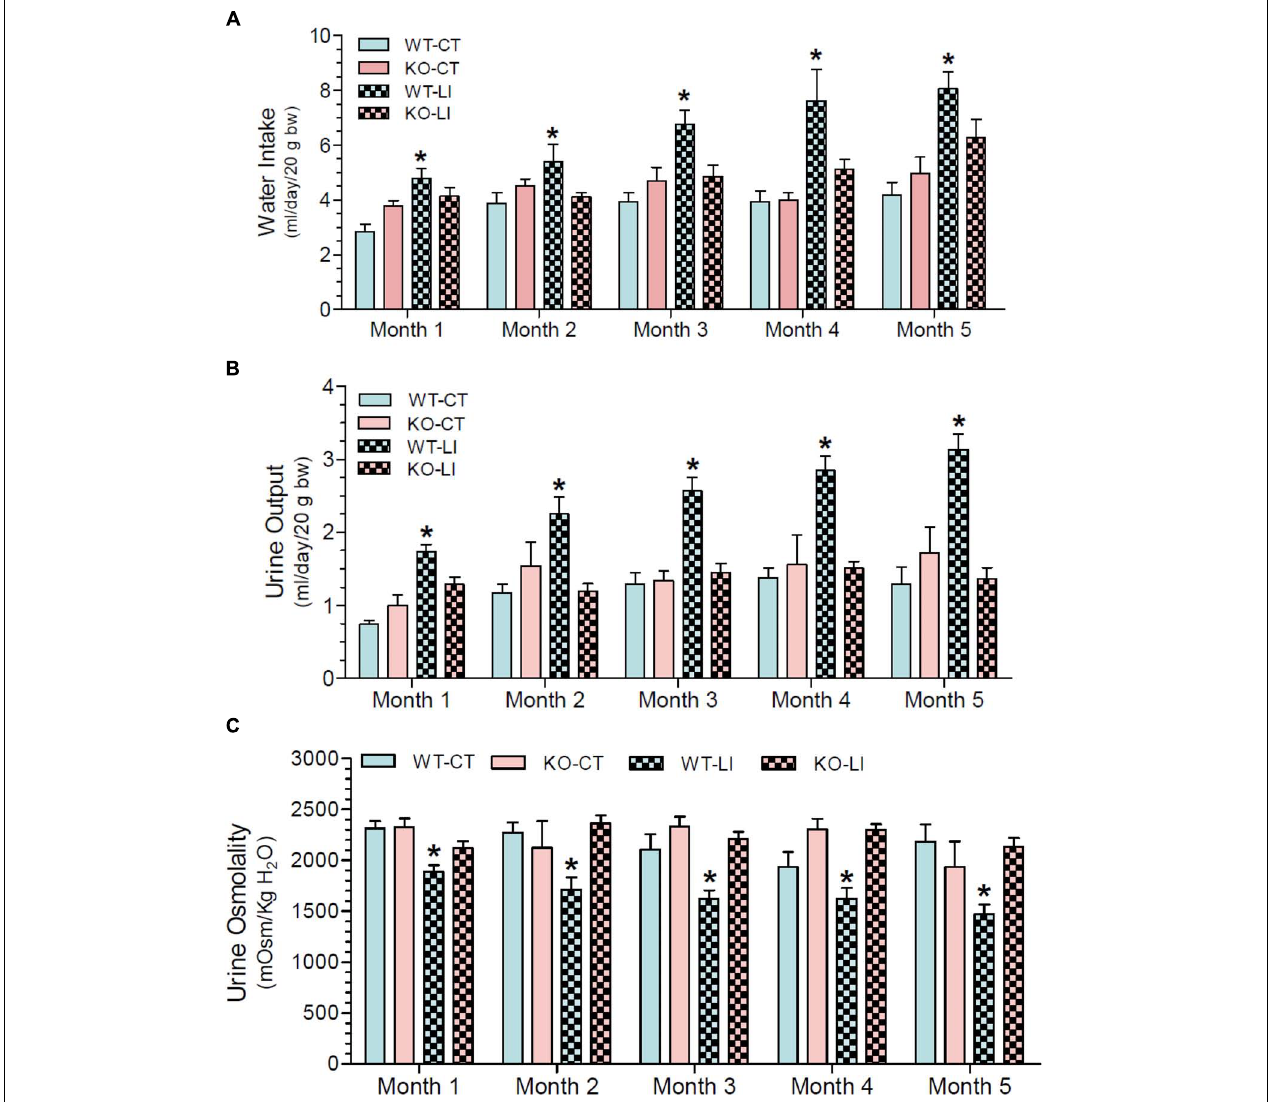
FIGURE 2 | Monthly record of water intake (A) , urine output (B) , and urine osmolality (C) in WT and P2Y 2 KO mice fed control or lithium-added diet for 5 months. Values shown are mean ± se (CT, n = 5 mice/genotype; LI, n = 10 mice/genotype) of two consecutive. One-way ANOVA: Water intake: ∗ significantly different from the corresponding WT-CT at all time points, and from the corresponding KO-LI at all time points except month 1. Urine output: ∗ significantly different from the corresponding WT-CT and KO-LI at all time points. Urine osmolality: ∗ significantly different from the corresponding WT-CT and KO-LI at all time